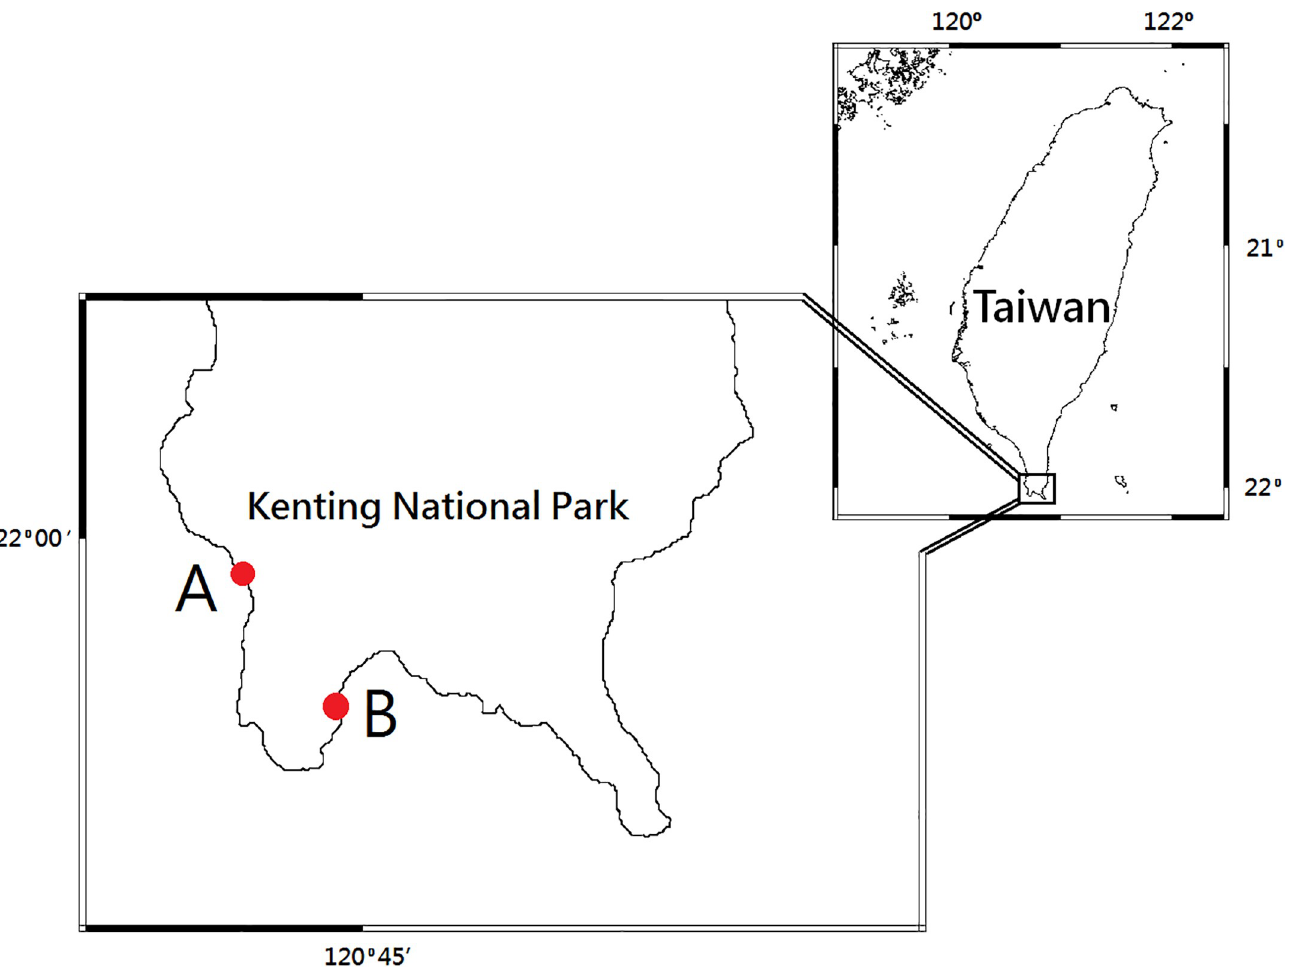
Fig 1. Study sites. (A) Wanliton (B)